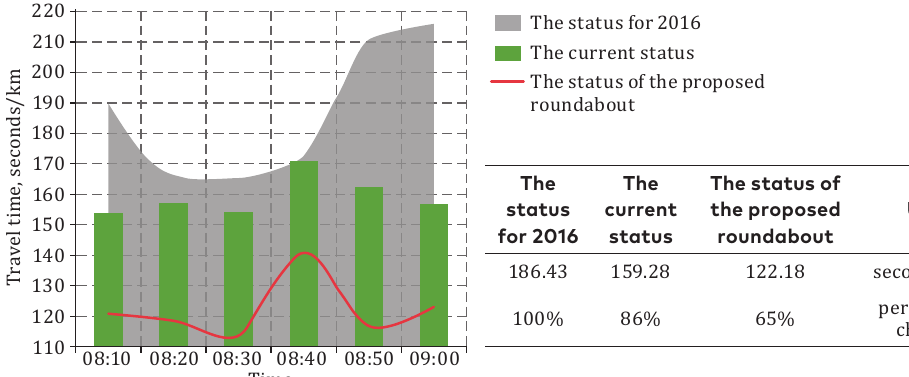
Figure 23. Vehicle travel time